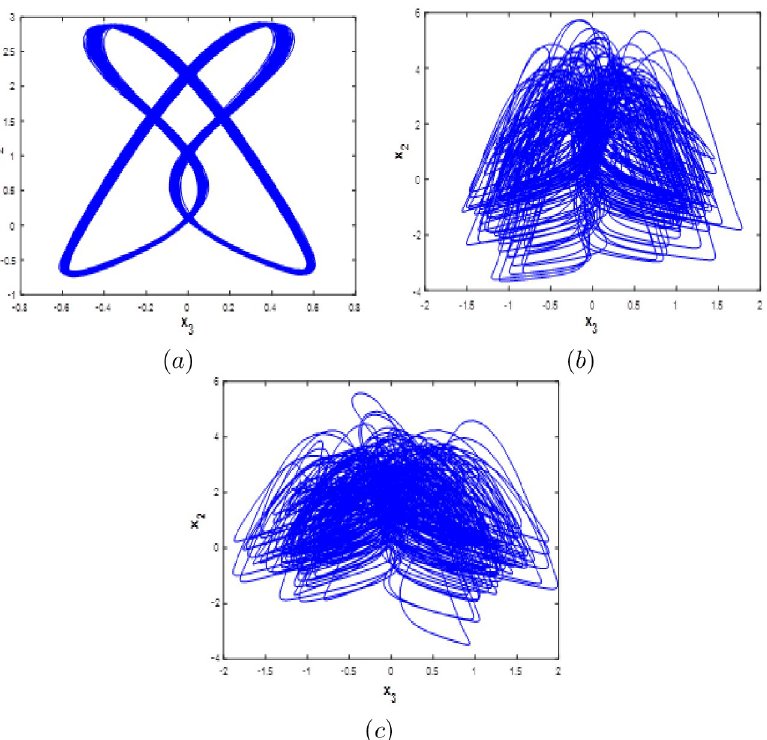
Fig 4. Phase portraits of the new 10-D system (1) for different values of a . (a) x 3 − x 2 Quasi-periodic attractor, (b) x 3 − x 2 chaotic attractor and (c) x 3 − x 2 hyperchaotic attractor.